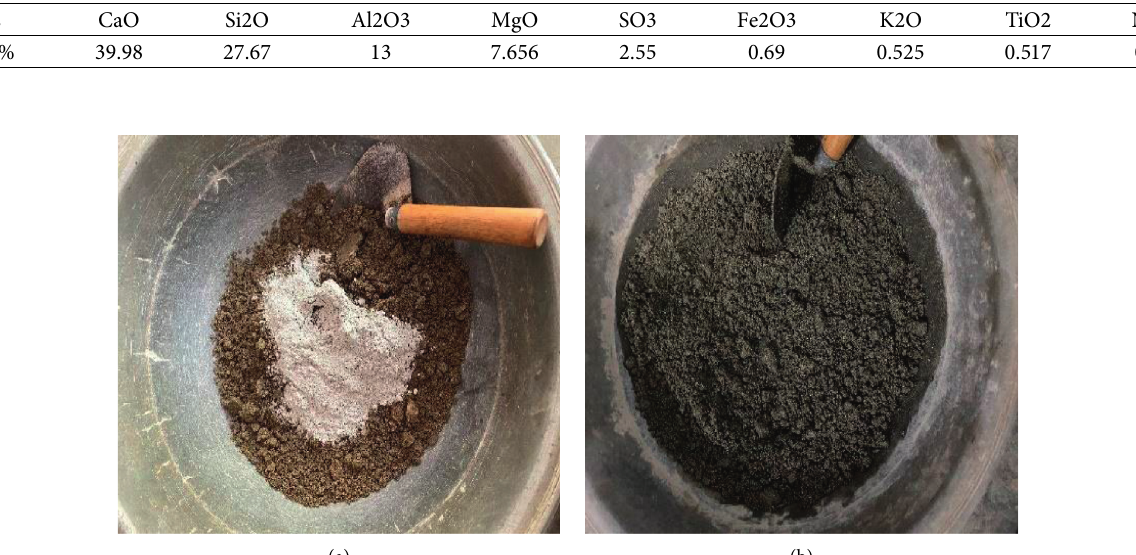
Figure 3: Mixing Process of the Recycled Mixture (a) before mixing (b) after mixing.